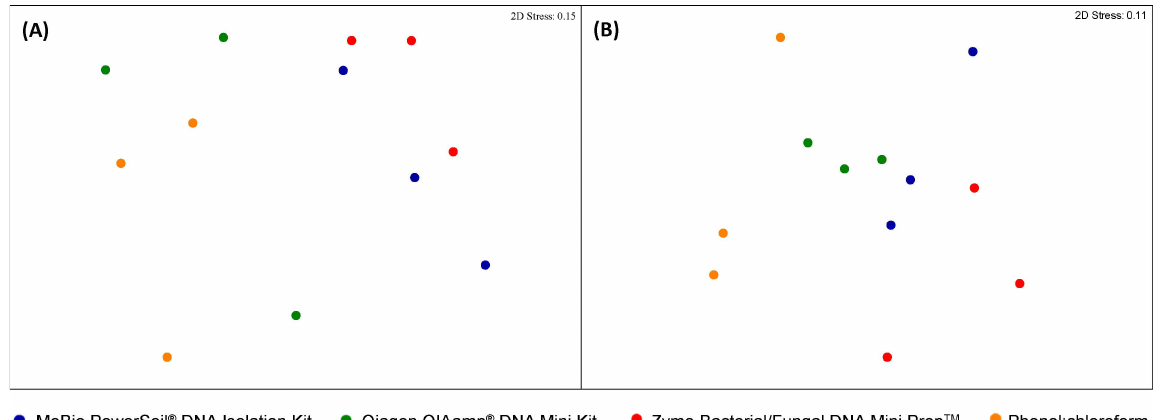
Fig 2. Non-metric multidimensional scaling(MDS) plots comparing relative unweighted UniFrac phylogenetic distances of bacterial communities in (A) plaqueand (B) saliva across the four DNA extraction methods.